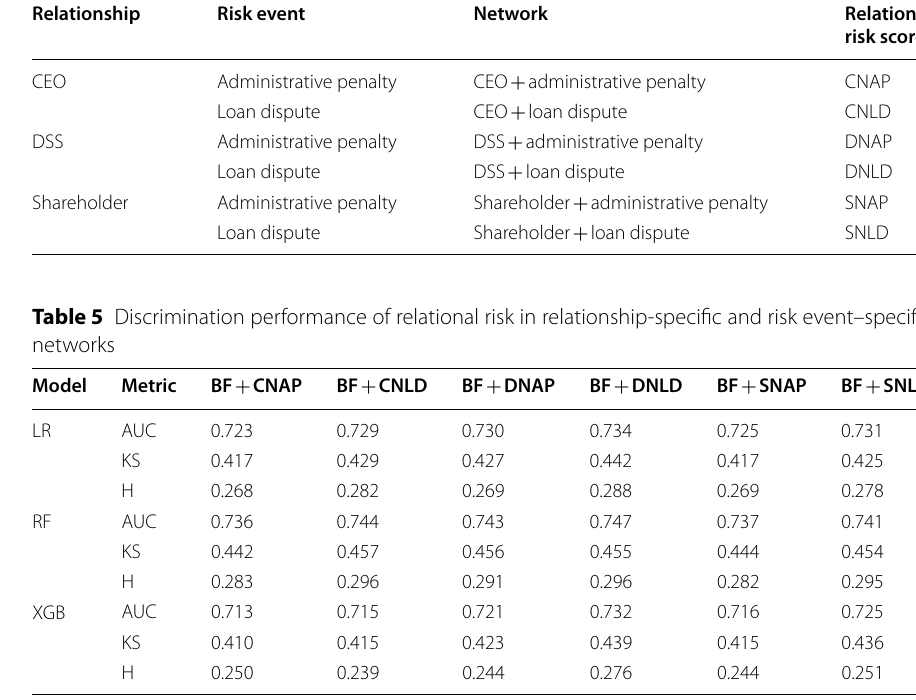
Table 4 Relationship- and risk event-specific networks and corresponding relational risk scores Relationship